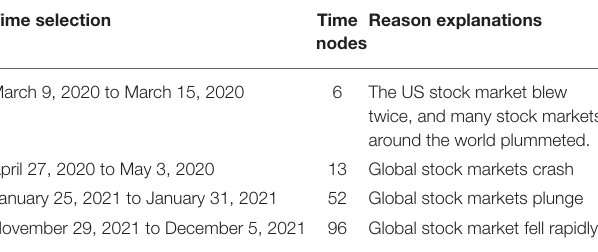
TABLE 5 | Time node selection and